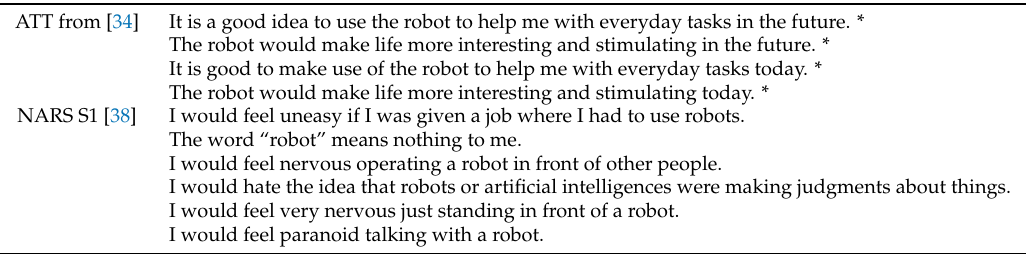
Table 2. The used attitude towards robots questionnaire.